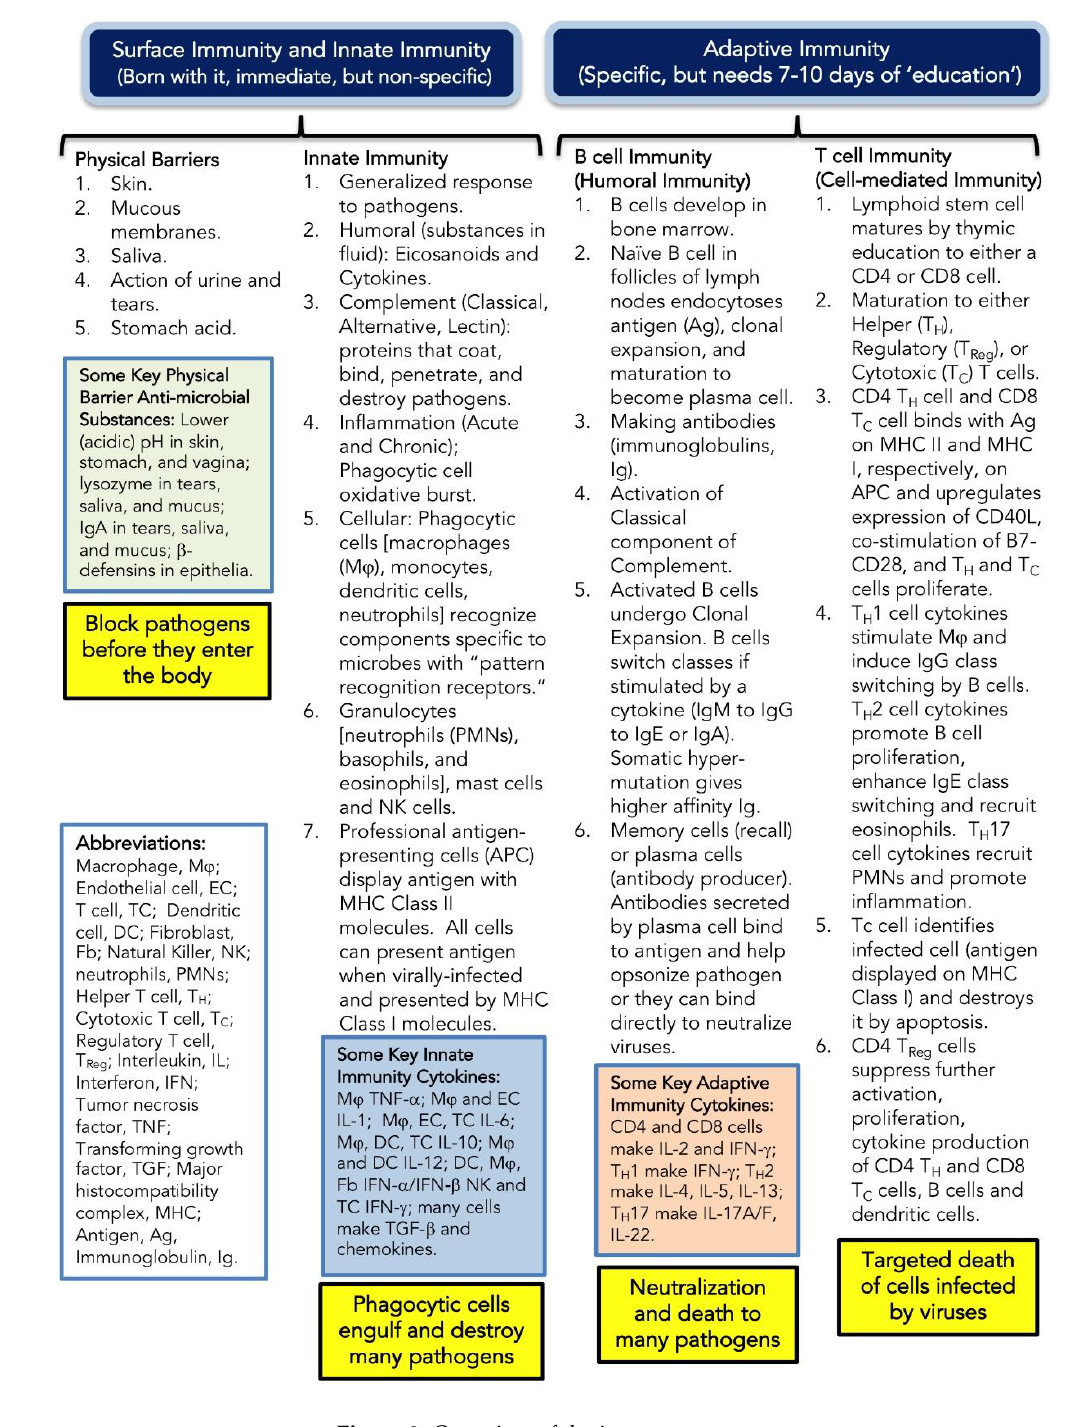
Figure 2. Overview of the immune system.